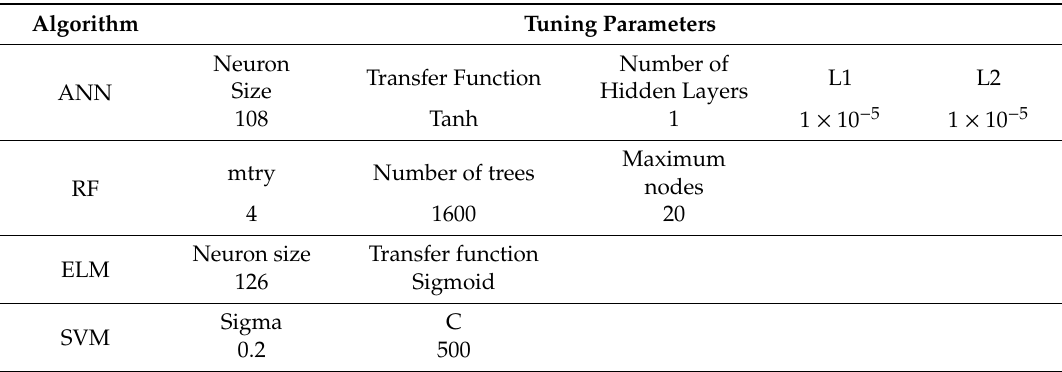
Table 6. Final tuning parameters of soft sensors obtained with the grid search.